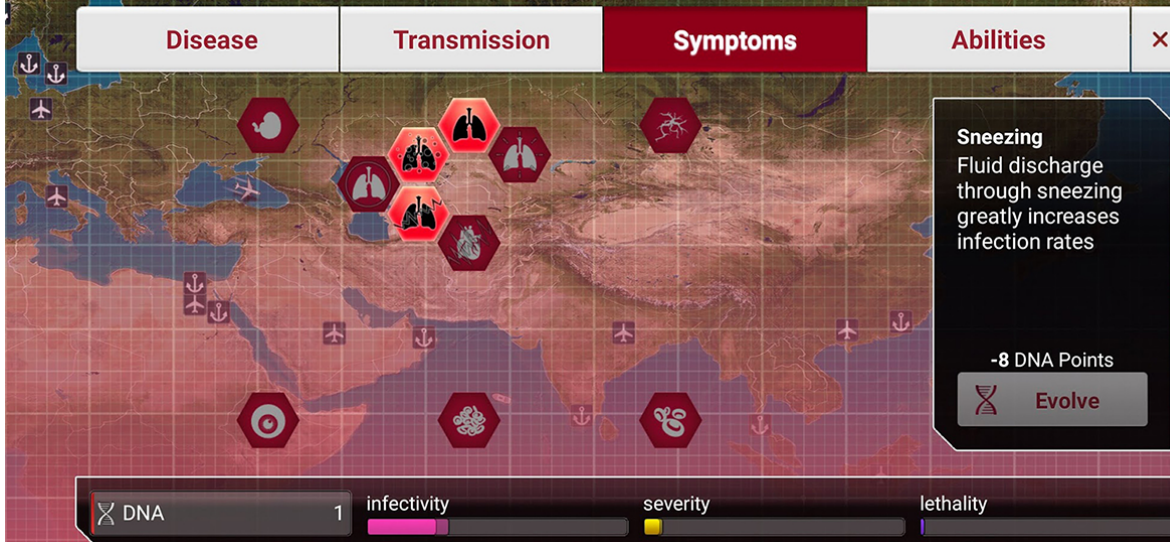
Figure 4. Screenshot of Plague Inc.: disease symptoms.